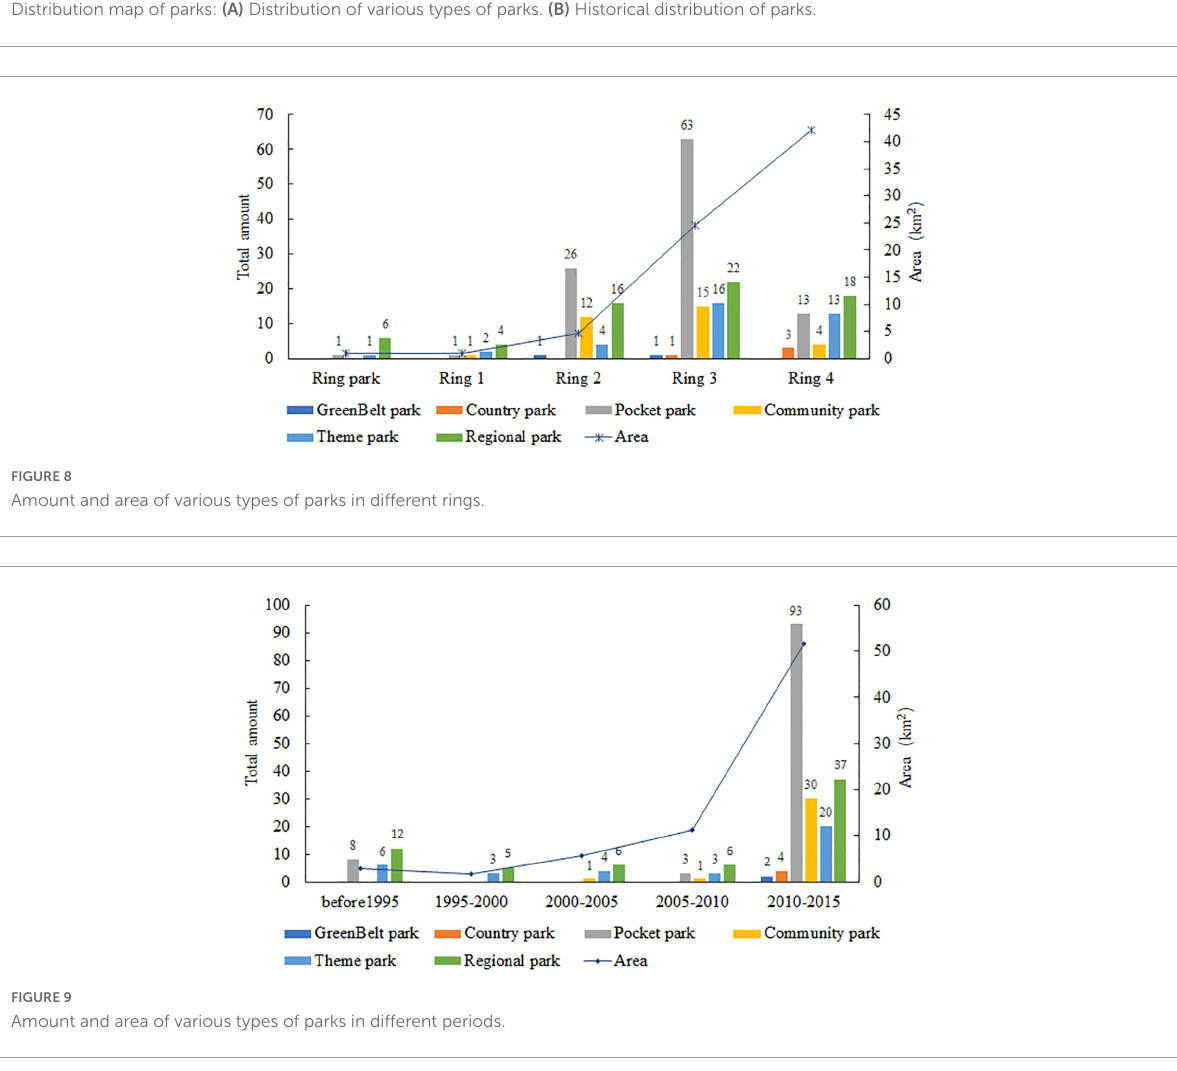
similar, at 1.83 and 1.37 km 2 , respectively. However, the Country park area is mainly distributed in Rings 3 and 4. The Community park area is mainly distributed in Rings 2 and 3. The GreenBelt Park land covers an area of only 0.22 km 2 , with one in Ring 2 and one in Ring 3.